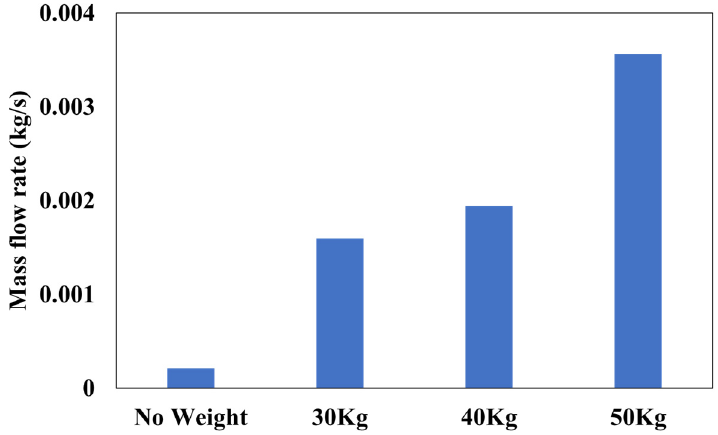
Figure 10. Comparison of mass flow rates with an assumption of spherical droplets.